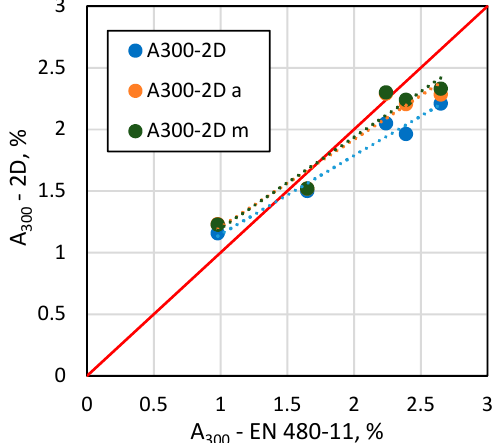
Figure 8. A comparison of EN 480-11 data versus the 2D analysis results for A: ( a ) all air voids, ( b ) air voids up to 2 mm in diameter.